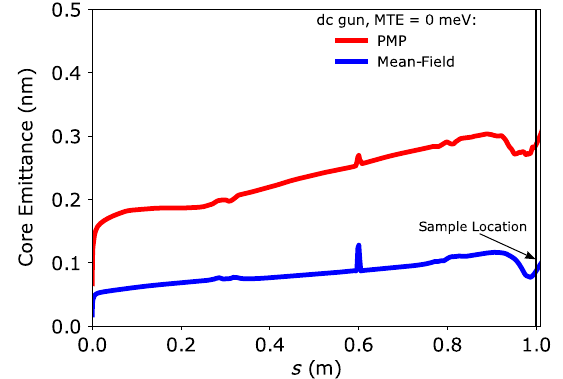
FIG. 10. Radial distribution function comparison between PMP and mean-field simulations of the NCRF UED beam line with 0 meV MTE ∼ 3 mm away from the cathode. Only a small r portion of the distribution is plotted to show the creation of the Coulomb hole when point-to-point space charge is used. For comparison, the distributions were normalized such that the mean of the radial distribution functions from 1.5 to 3 . 0 μ m is equal to